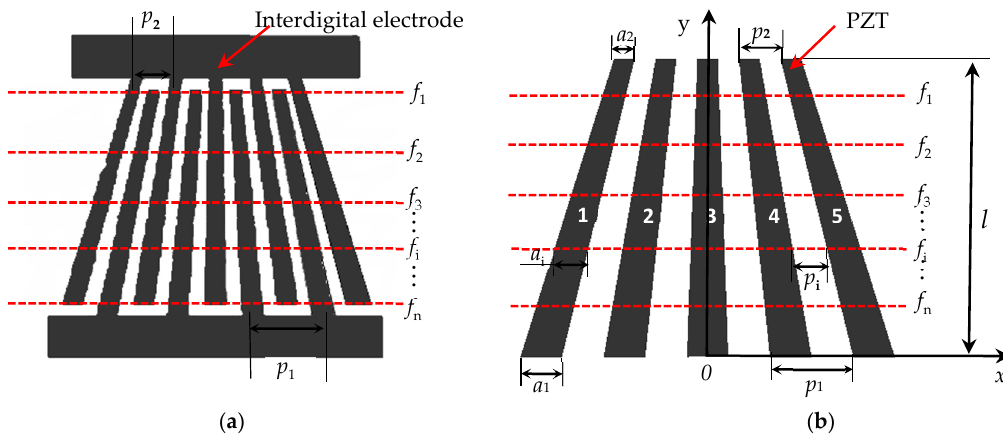
Figure 1. Non-equidistant comb transducer schematic diagram ( a ) Slanted Finger Interdigital Transducers (SFIT) ( b ) Non-equidistant comb transducer.